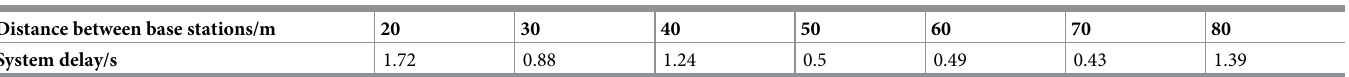
Table 1. Base station distances and system delays.